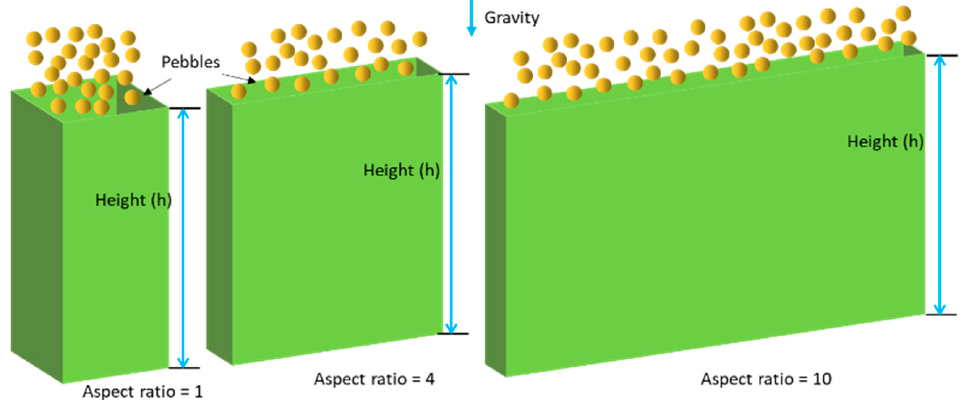
Figure 1. Filling process of the pebbles packed in rectangular containers.